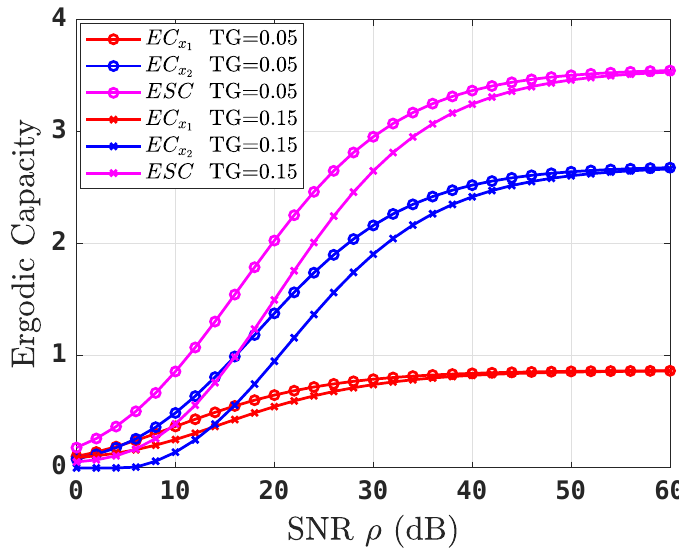
Figure 9. The effect of temperature gradient on ECs performance.